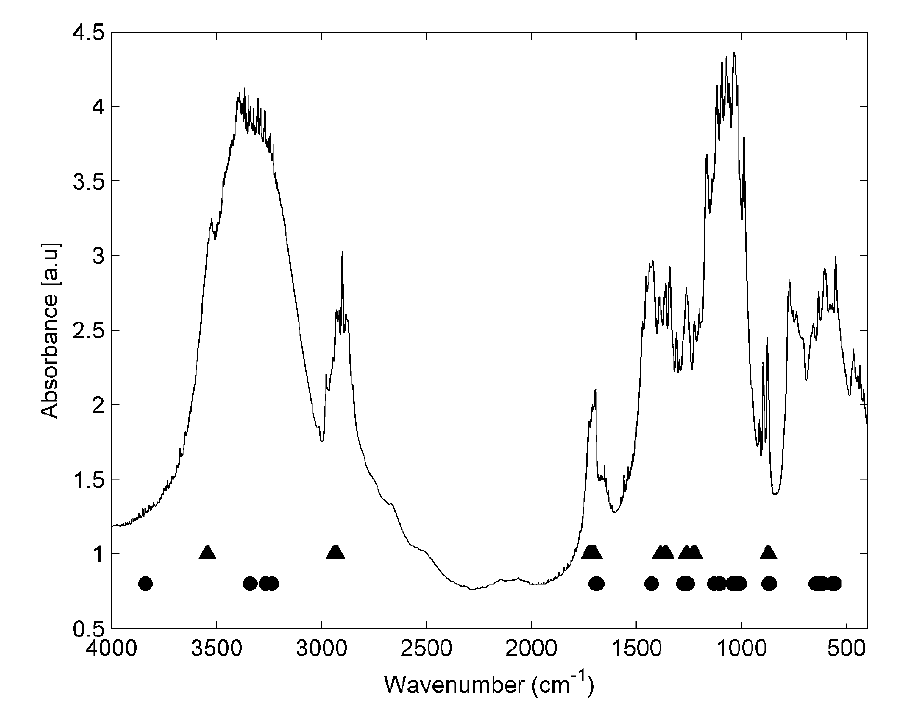
Figure 6. The mean FT-IR spectra (the calibration set) and variables selected after application of UVE-PLS for modelling lovastatin (triangles) and wavenumbers for characteristic peaks for lovastatin IR spectrum